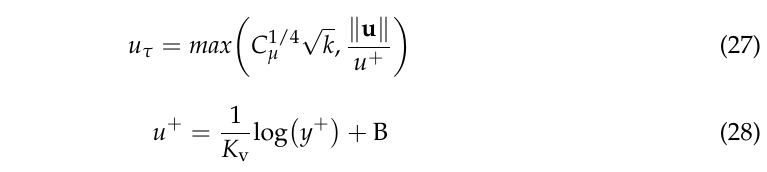
Figure 4. Maximum erosion rates for different mesh numbers at a fluid flow rate of 15 m/s. Table 3. Effect of mesh addition on time and difference variation. Mesh numbers